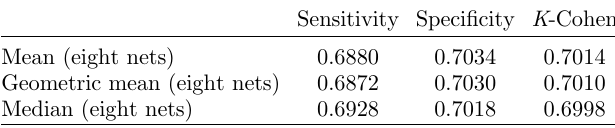
Table 6. Summary of results of Table 5. Table 8. Interpretation of